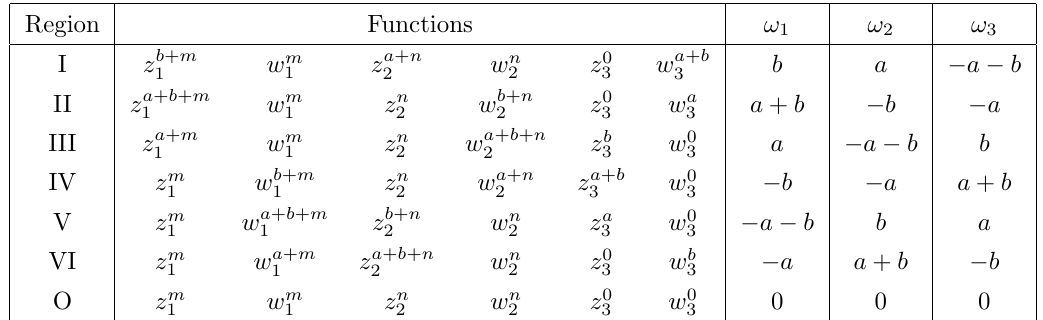
Table 1 . Holomorphic functions on C ( S ) and their weights under ! 1 ; 2 ; 3 . All functions have (cid:22) - weight 2( a + b + m + n ). Here m; n; a = 0 ; 1 ; 2 ; : : : , but b = 1 ; 2 ; 3 ; : : : , to avoid overcounting the borders between the regions. We have included the origin O separately (where a = b =